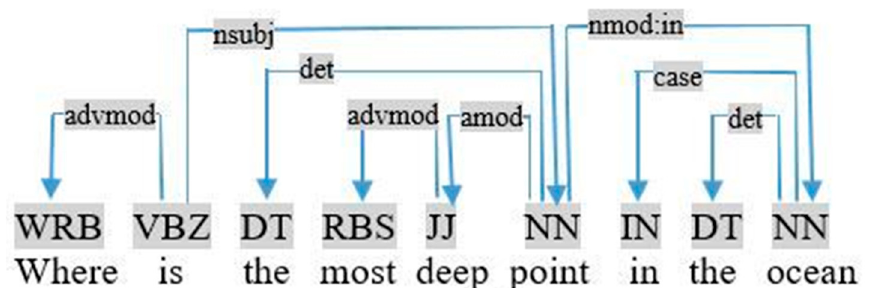
Figure 16. Graph dependency of the query «where is the most deep point in the ocean».